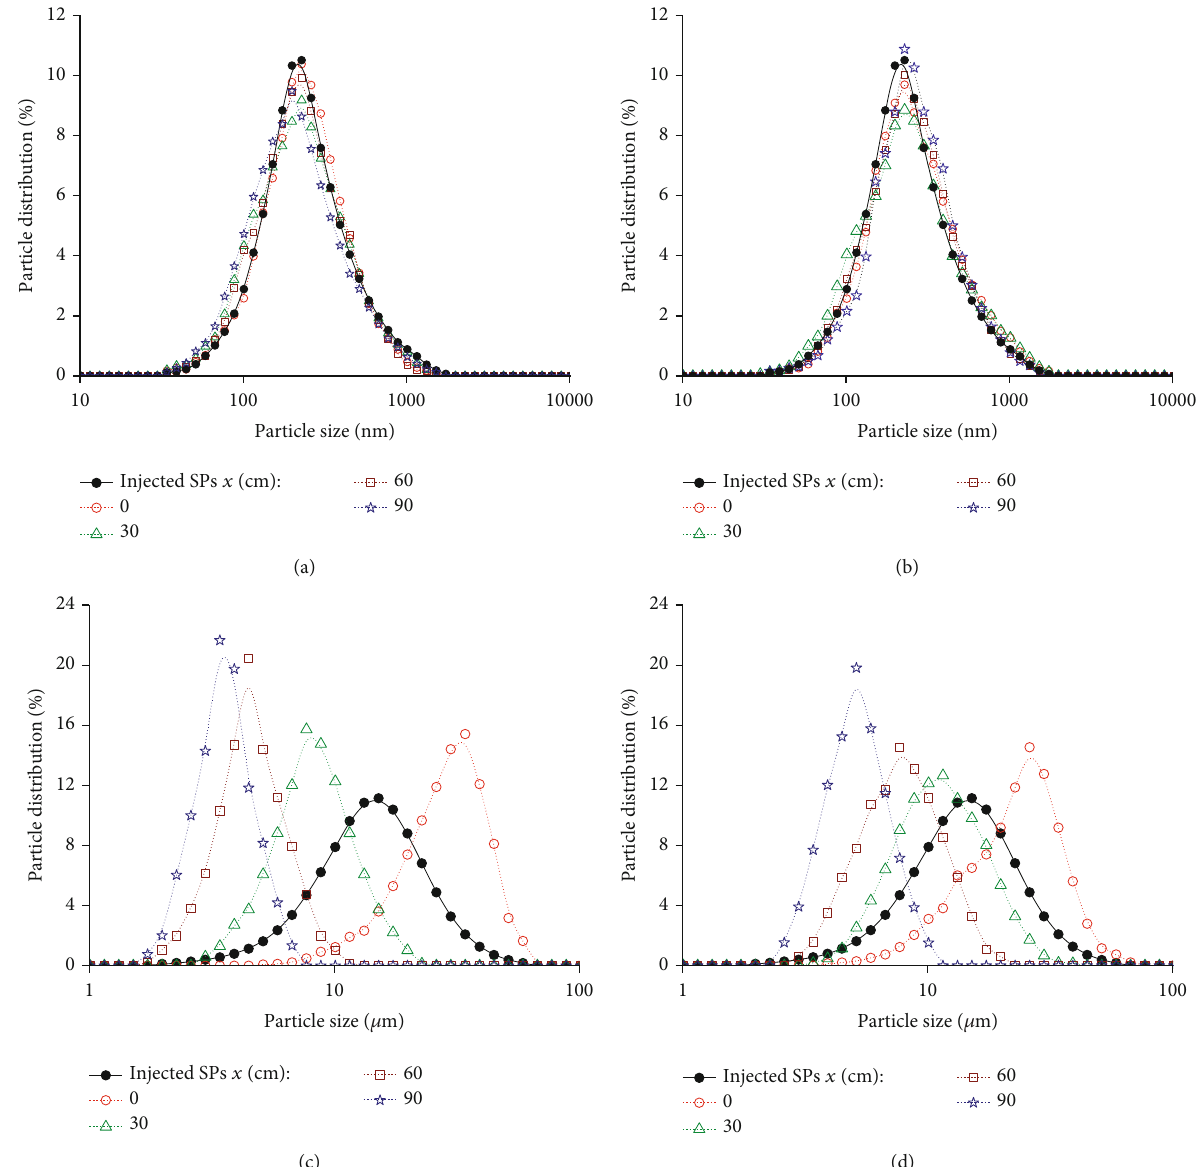
Figure 6: Particle gradation curves of the SPs: (a) v = 0 : 087cm/s , D = 13 : 24 μ m ; and (d) v = 0 : 087 cm/s , D